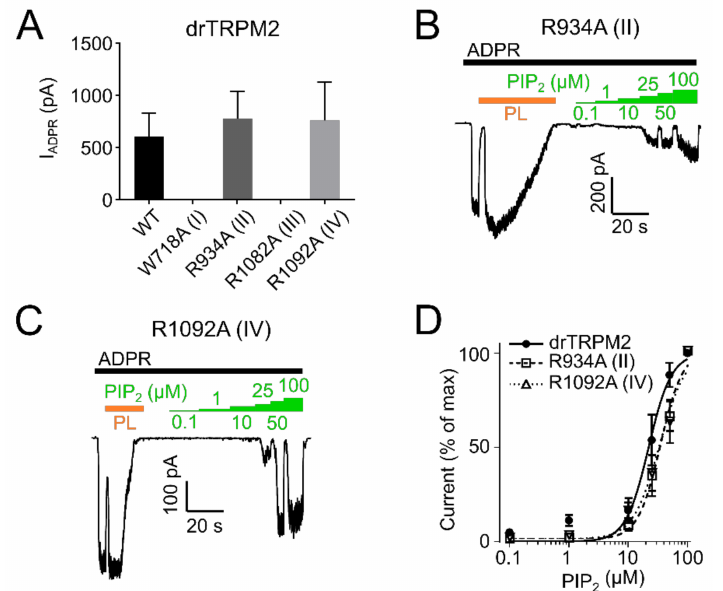
Figure 7. PIP 2 sensitivity of drTRPM2 membrane interfacial cavity mutant channels. ( A ) ADPR (100 µ M, black bar) induced currents of wild-type and mutant drTRPM2 channels. Current trace of R934A (II) ( B ) and R1092A (IV) ( C ) perfused with increasing concentrations of PIP 2 (green bars). Polylysine (15 µ g/mL, PL, orange bar) was used to scavenge PIP 2 since even in the absence of external PIP 2 the channels are already saturated with natural membrane PIP 2 . ( D ) Summary of the presented data showing a right shift in PIP 2 sensitivity of mutants R934A (II) and R1092A (IV). Data represented as mean ± SEM; n =